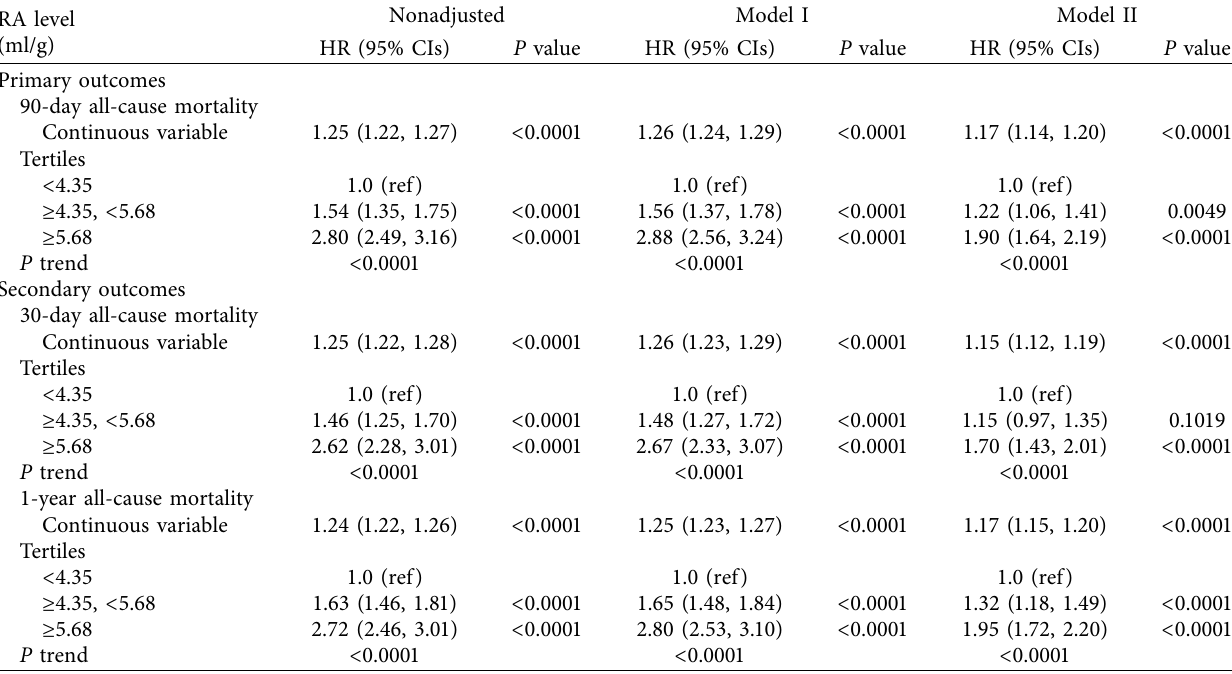
Table 2: HRs (95% CIs) for all-cause mortality across groups of RA level.